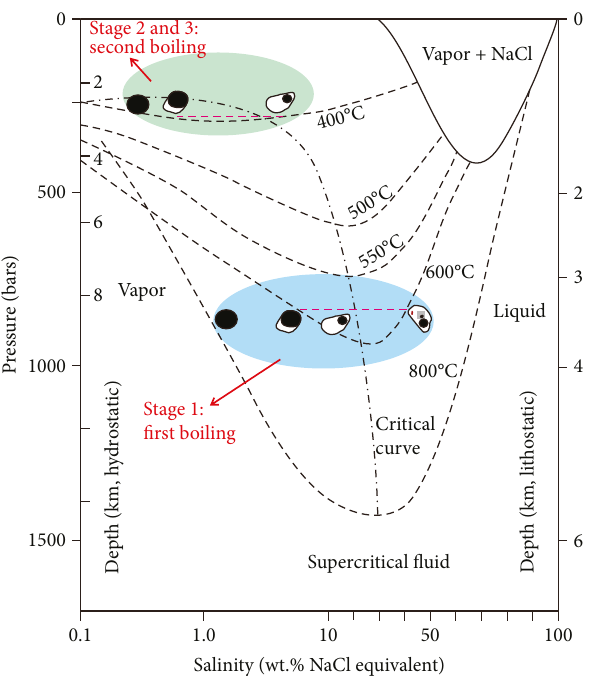
Figure 14: Fluid evolution paths of the Fuzishan Cu-Mo deposit Figure 13: Isothermal P-T-X phase diagram of fl uid inclusions in (NaCl-H O system) (modi fi ed after Meinert et al. [3]; Peng et al. 2 the Fuzishan Cu-Mo deposit (NaCl-H O system) (modi fi ed after [48]; Shu et al. [62]). The two paths show that separated two- 2 Zhou et al. [8]). Light blue and dark green ellipses represent fi rst phase (vapor and hypersaline) fl uids come from the initial boiling in stage 1 and second boiling in stages 2 and 3, supercritical fl uid with salinity of 6 to 8wt.% NaCl equivalent. The respectively. Schematic diagrams of fl uid inclusions show the fl uid blue path indicates that the trajectory hits the solvus at 550 to types generated at di ff erent salinities and same temperatures and about 650 ° C and at a pressure of 700 to 1000 bars (equal to pressures during the fl uid phase separation. lithostatic depth of 2.6 to 3.7km) in the prograde skarn stage. The green path indicates that the trajectory hits solvus around 350 to 400 ° C and at pressure of 150 to 280 bars (equal to hydrostatic depth of 1.5 to 2.8 km) both in retrograde skarn and quartz-sul fi de stages. See more details in the